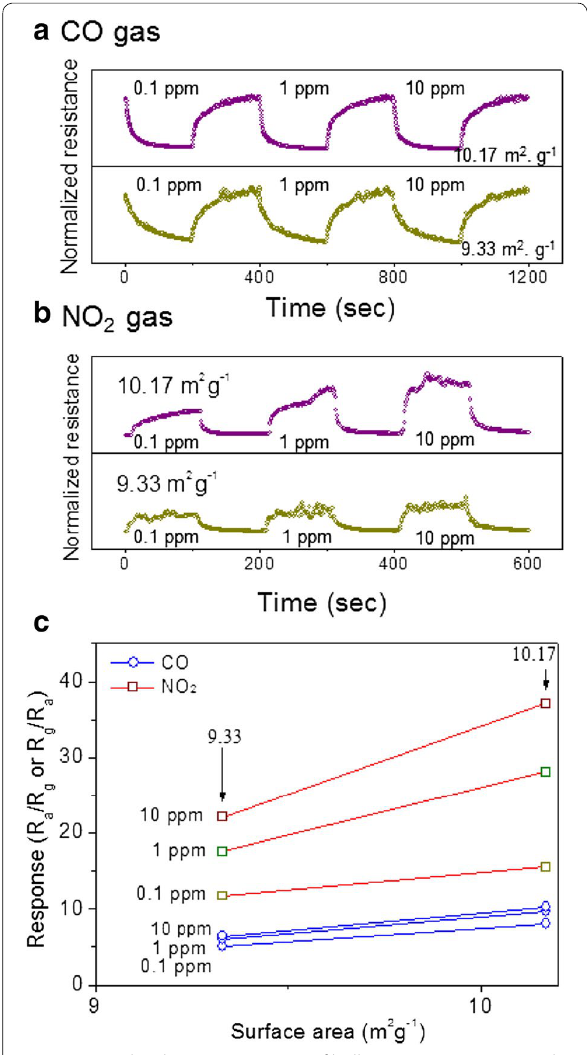
Fig. 4 Normalized resistance curves of hollow ZnO NW sensors with different surface areas towards 0.1, 1, and 10 ppm of a CO and b NO 2 at 400 °C. c Response versus surface area for hollow ZnO NWs sensor with different surface areas at different concentrations of CO and NO 2